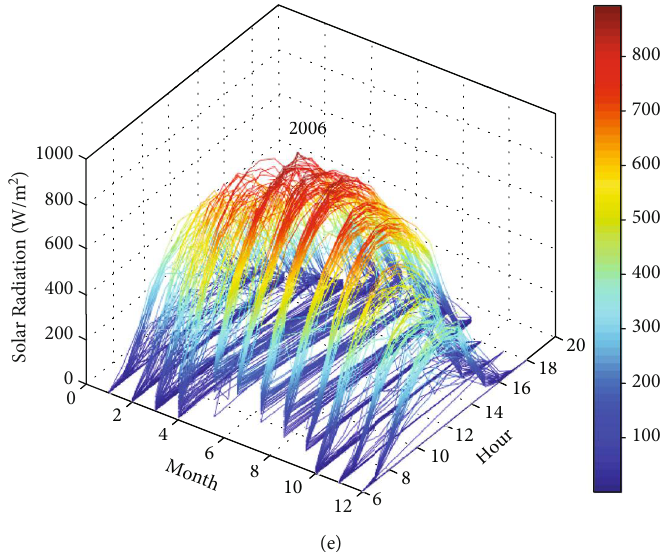
Figure 4: The 3D distribution graphs of HAGSR of Kahramanmaras measured for the years (a) 2002, (b) 2003, (c) 2004, (d) 2005, and (e) 2006. Table 1: Speci fi c characteristics of geographical and meteorological data of each province. Selected